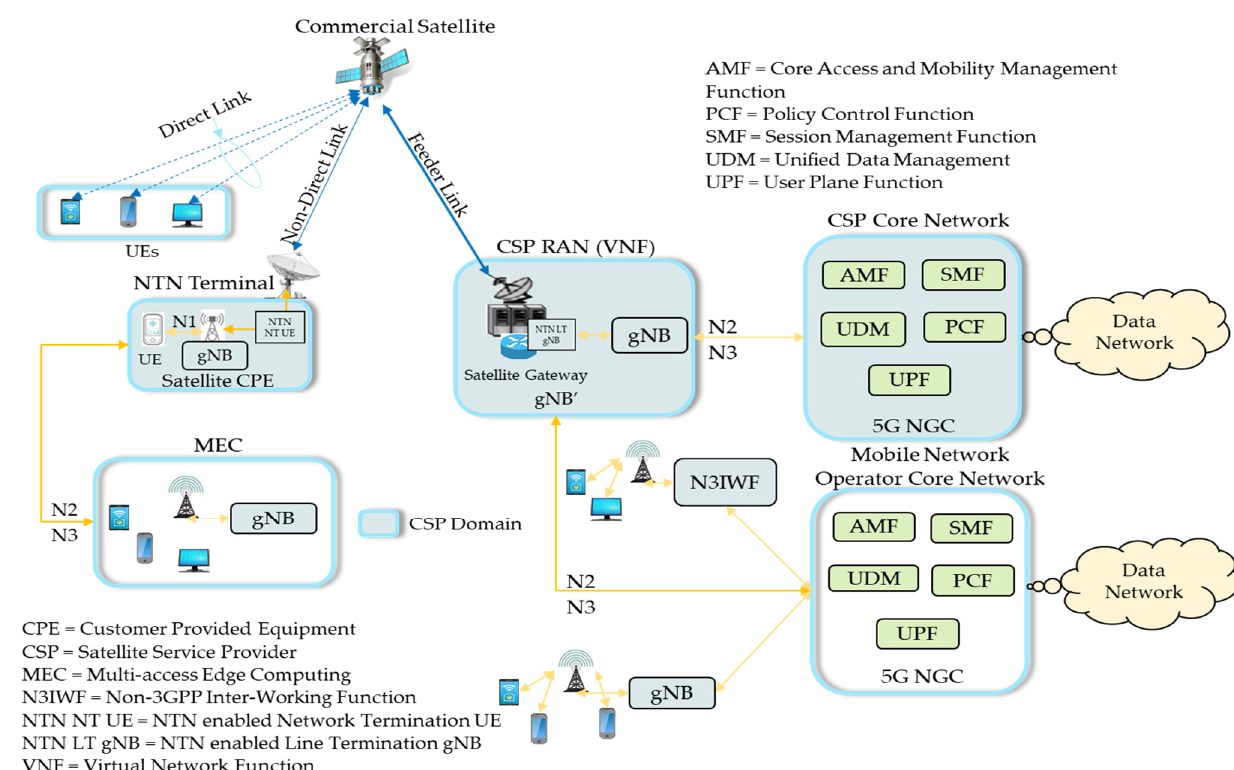
Figure 14. Top-level SATi5 architecture perspective for commercial applications.